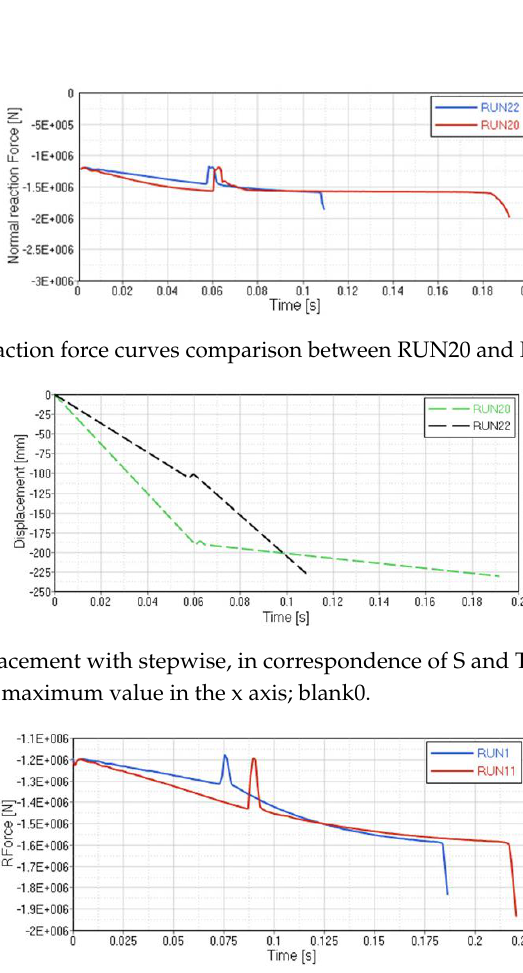
4 of 21 Figure 10. % Thinning distribution and X1, X2, Y1 and Y2 values for the RUN20; blank0. Figure 11. % Thinning distribution and X1, X2, Y1 and Y2 values for the RUN1; blank1.